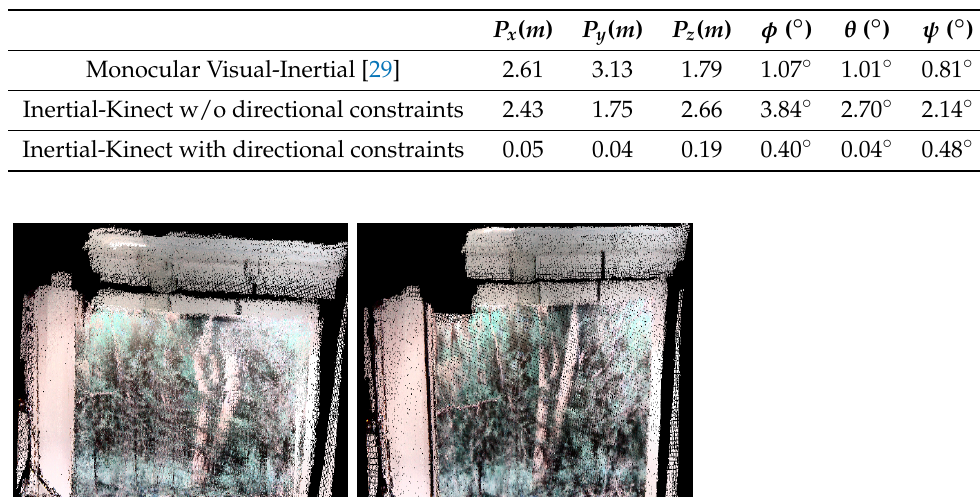
Table 1. Evaluation of proposed approach against Vicon outputs (RMSE error).